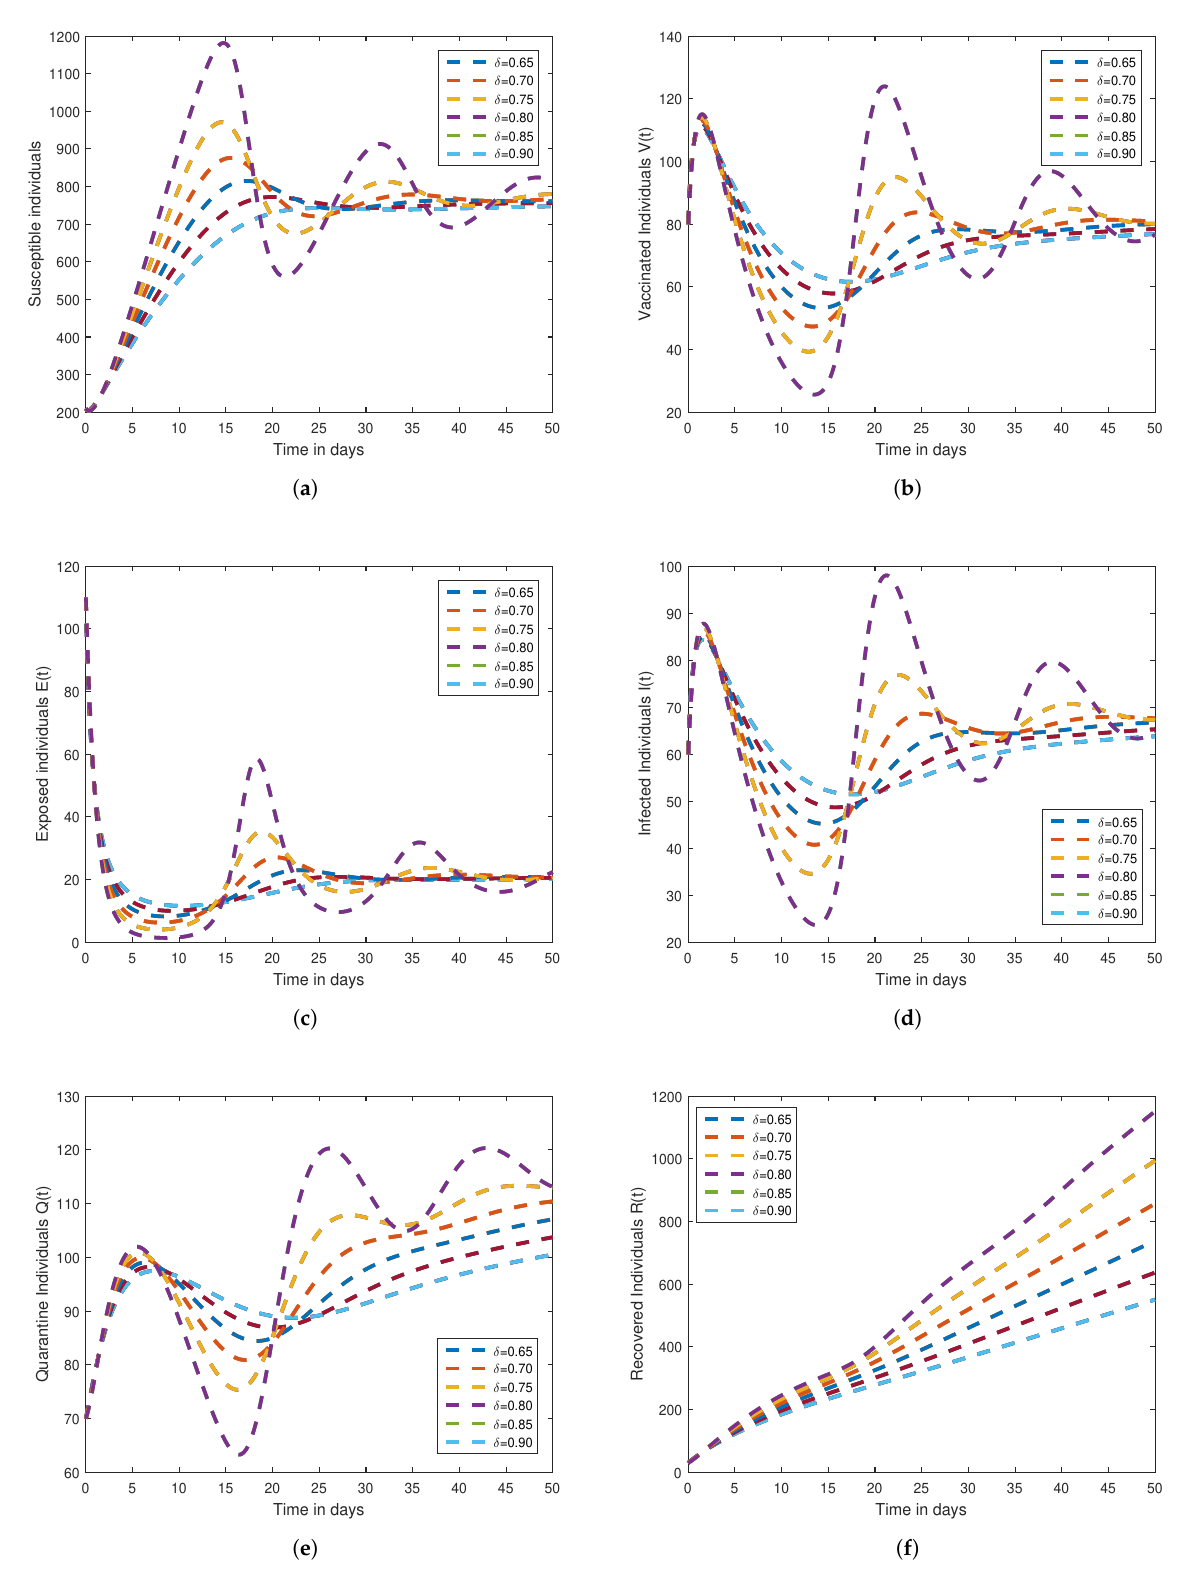
Figure 7. The behavior of each state variable is depicted in the figure for θ = 0.01815. Furthermore, the figures ( a – f ) represents susceptible people S ( t ) , vaccinated people V ( t ) , exposed people E ( t ) , infectious people I ( t ) , quarantined people Q ( t ) , and recovered people R ( t )